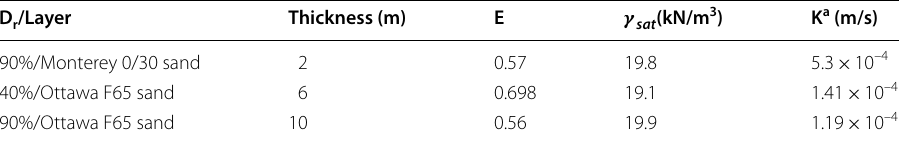
a K estimated in laboratory by constant head permeability